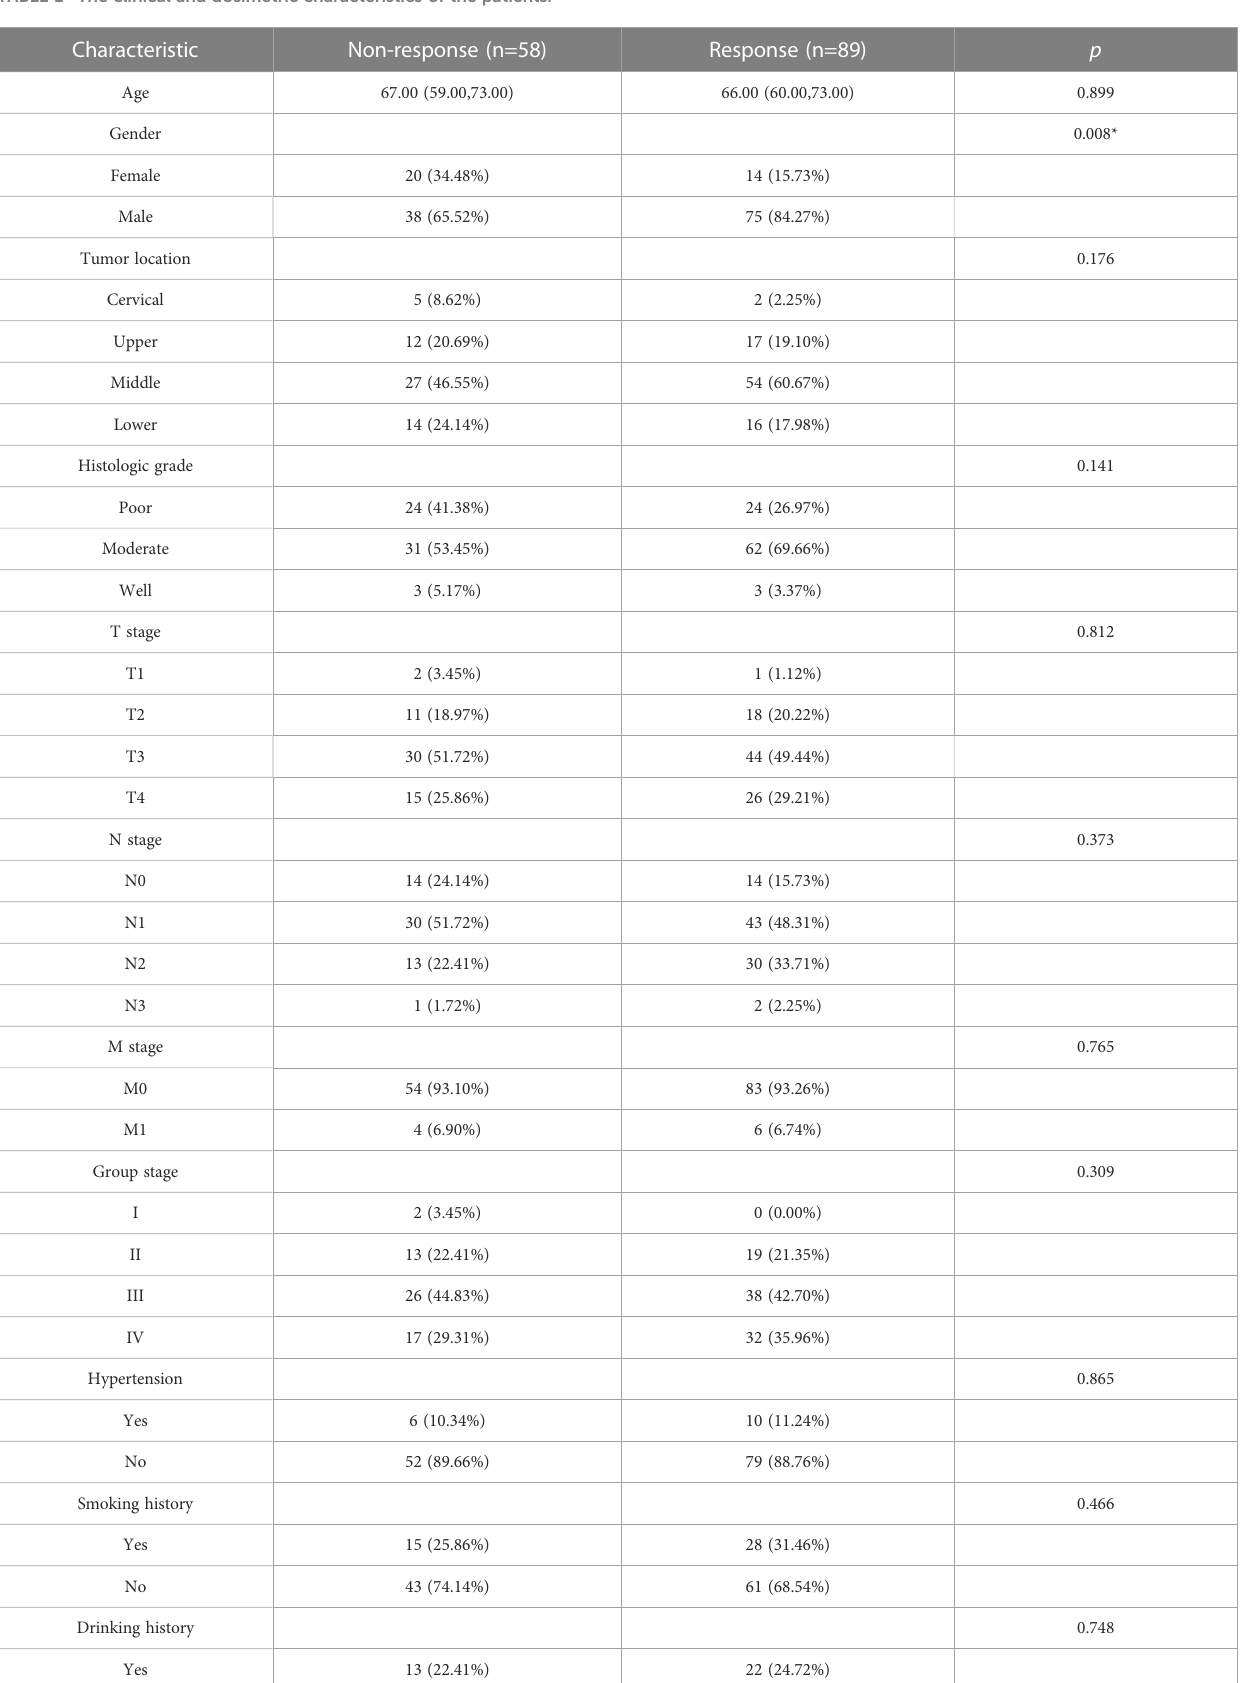
TABLE 1 The clinical and dosimetric characteristics of the